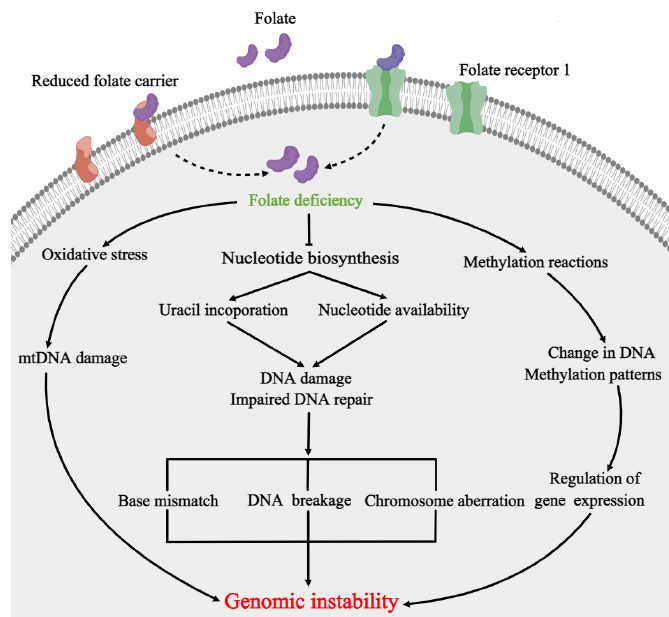
Figure 3. The association of folate deficiency and genomic instability. Folate is taken into cells through Folate receptor 1 or Reduced folate carrier to be used in nucleotide biosynthesis, methylation reaction and oxidative stress. Folate deficiency affects the normal biological functions of the cell, resulting in the impairment of genomic stability. Folate deficiency induces increase in uracil incorporation and decrease in nucleotide availability, which causing DNA damage that cannot be repaired efficiently, leading to base mismatch, DNA breakage, and chromosome aberration. As methyl donors, low folate can alter methylation patterns, resulting in changes in gene expression. Folate deficiency also causes oxidative stress with consequences that affect the integrity of mitochondrial DNA.